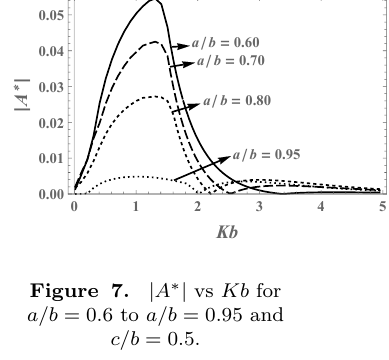
Figure 6. | A ∗ | vs Kb for a/b = 0 . 25 to a/b = 0 . 45 and c/b = 0 . 5 .